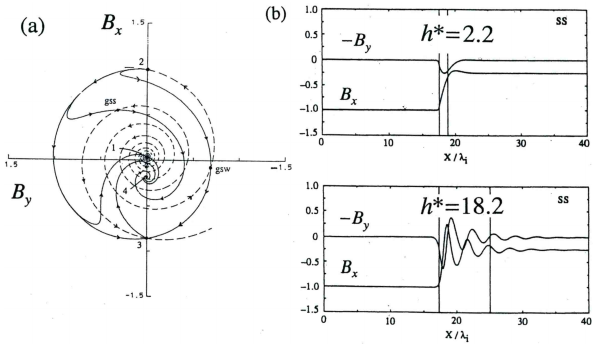
Fig. 37. Magnetic structure of shocks in Hall MHD. (a) Exam- ple showing the behavior of the magnetic field components in the shock plane (compare to lower left shock in Fig. 36) for small re- sistivity. The slow-shock upstream and downstream states are at points 3 and 4, respectively (also, fast shock: 1 → 2 ; intermedi- ate shocks: 1 → 3 , 2 → 3 , 1 → 4 , 2 → 4). The magnetic-field and flow components across the shock are both directed out of the plane of the paper (along +ˆ z ). (From Hau and Sonnerup, 1990). (b) Spa- tial profiles of the field components, B x and B y , tangential to a slow shock (compare to lower left shock in Fig. 36) for h *=2.2 and h *=18.2, where h * is the ratio of ion-inertial length, λ i , to resis- tive length, λ r . Upstream parameter values are: Alfv´en number A 3 = 0 . 91; shock angle θ 3 = 85 ◦ ; plasma pressure to magnetic pres- sure β 3 = 0 . 04. (From Hau and Sonnerup,